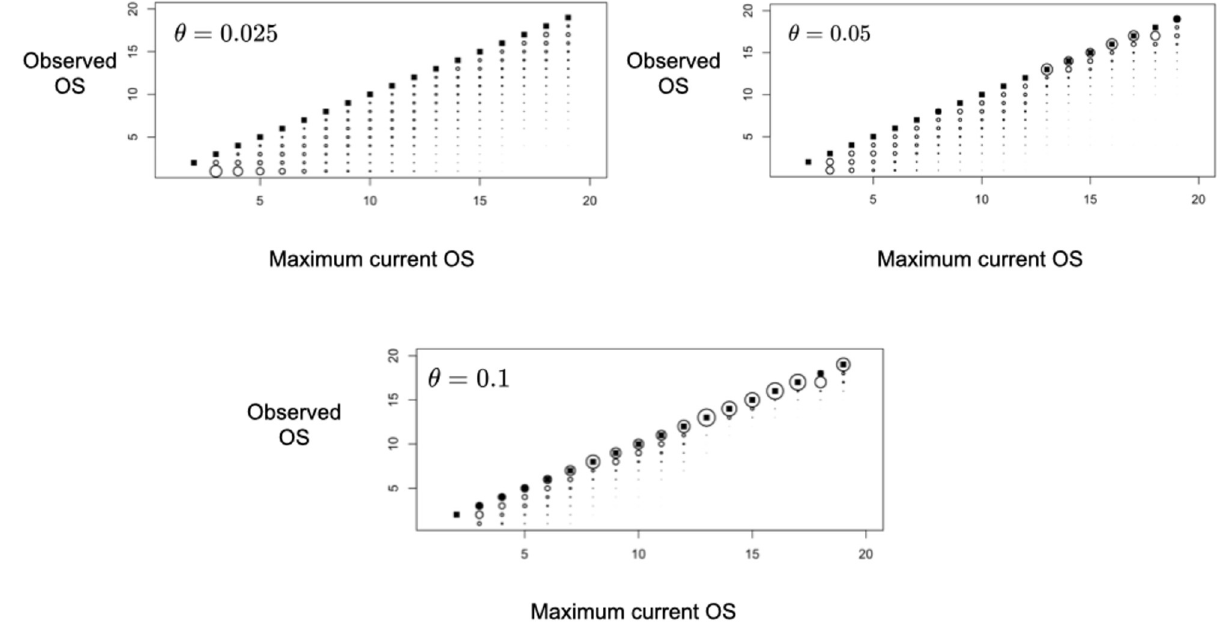
Fig 11. Simulation of the distribution of 1000 OSs for the updating distribution in Eq 16 and three different values of θ . Squares show the most recent OS, and circles show the fraction of the 1000 simulated cyber components in the respective OS. For ease of viewing, the fraction is multiplied by 3. This figure should be compared with the data in Fig